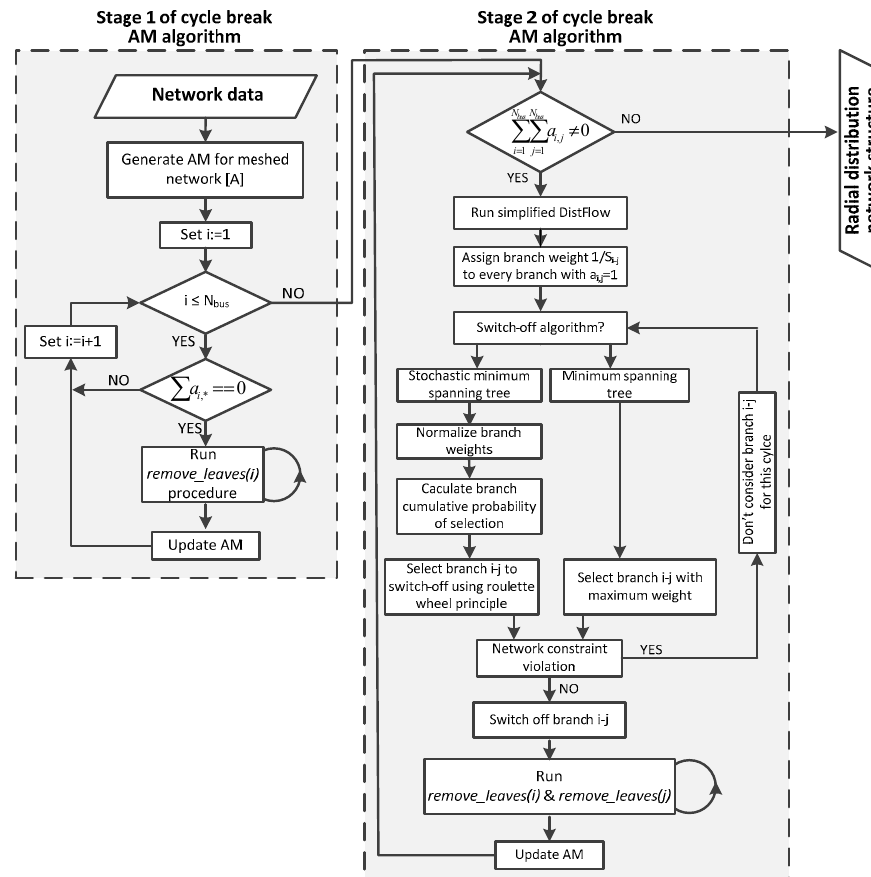
Figure 2. Initial population generation using the AM cycle break algorithm.